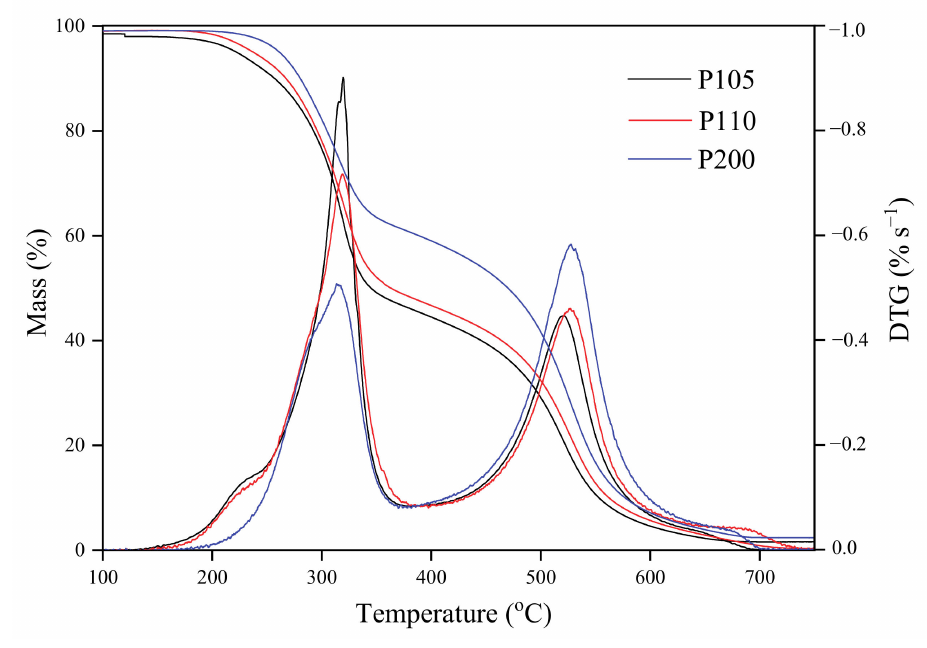
Figure 2. TG and DTG curves of P105, 110, and 200 in the air at 10 ◦ C min − 1 . Table 2. Pyrolysis parameters of PUs with different heating rates in the air atmosphere.